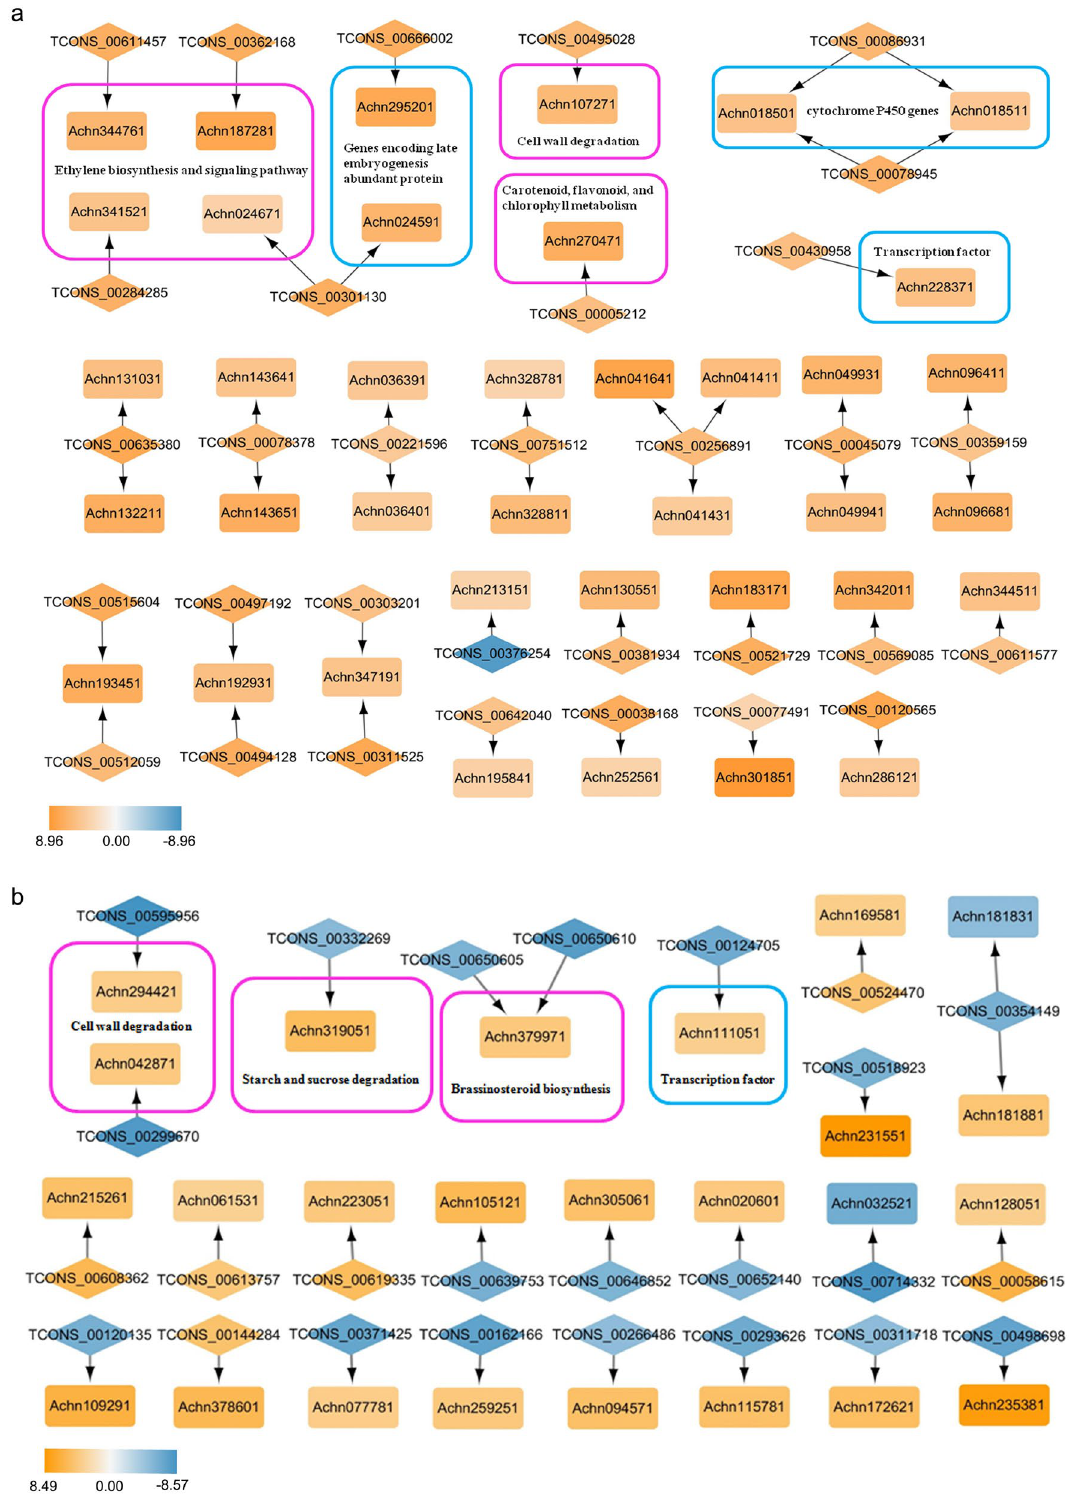
Figure 9. Co-localization network of DELs and DEGs in ABA vs. CK ( a ) and RT vs. CK ( b ). DELs were marked with diamonds, and DEGs were marked with rectangles. Upregulated genes were indicated in orange, while downregulated genes were indicated in blue. The orientations of the predicted regulatory relationship were indicated by the directions of the